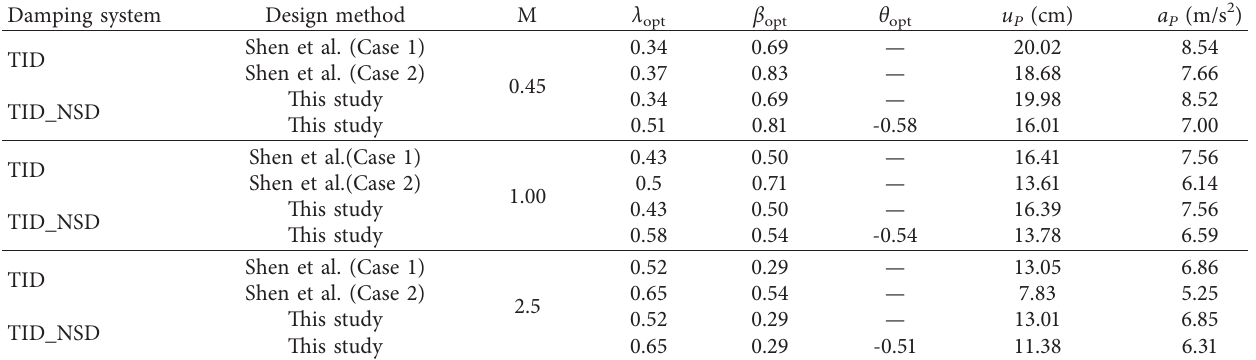
Table 3: Maximum displacement response and absolute acceleration of the primary system under earthquake record LA16. Damping system